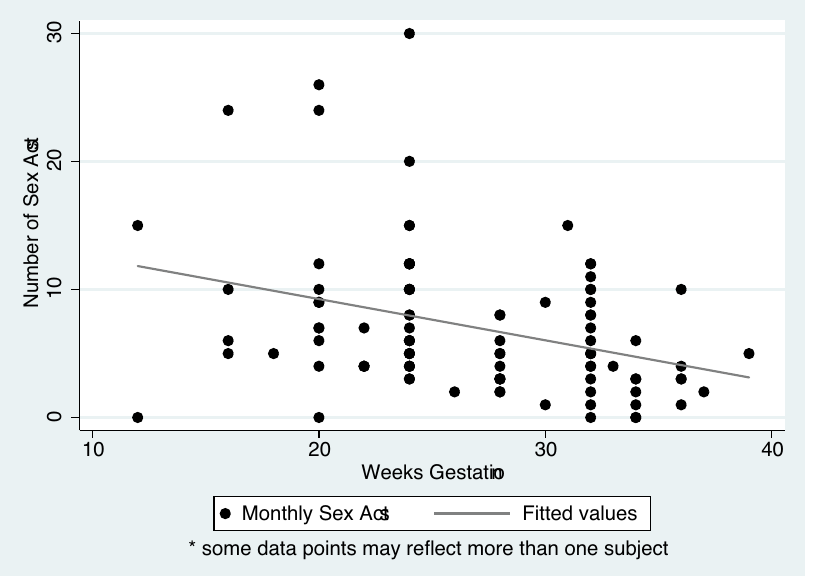
Figure 3. Monthly Sex Acts by Weeks Gestation. Comparing the monthly sex acts of all pregnant participants at various weeks gestation, sexual activity significantly declined as pregnancy advanced with Pearson’s correlation coefficient of 2 0.322 and p value of 0.001.